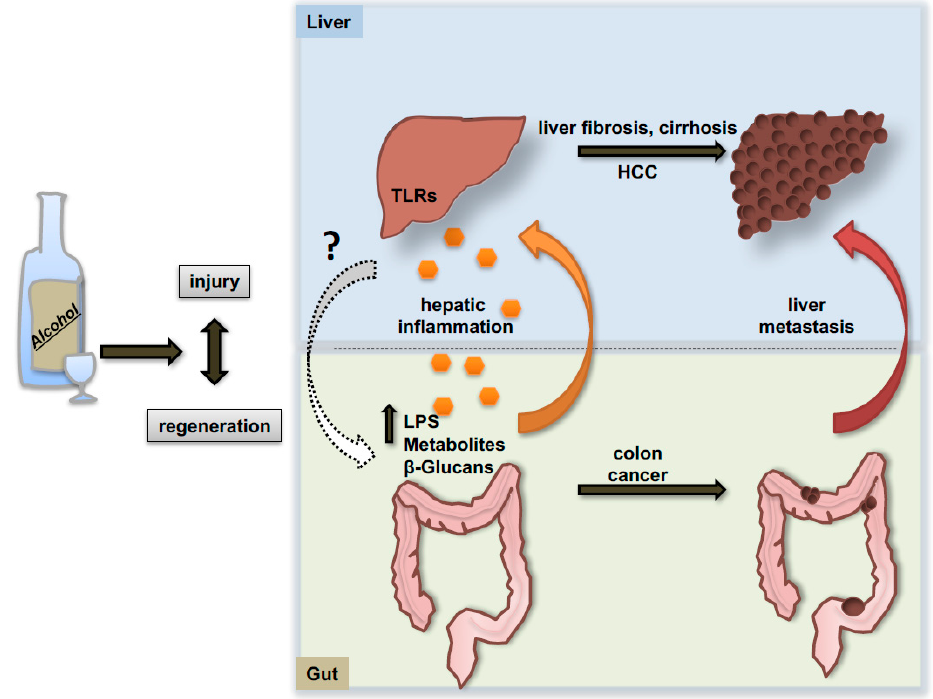
Figure 4. Gut-liver axis in the patho-physiology of alcoholic liver disease. Alcohol cyto-toxicity strongly affects the balance between hepatocyte death and proliferation through mechanisms not fully understood. Similarly, also the intestinal epithelial cells seem to be particularly susceptible to alcohol toxicity resulting in dysbiosis and alteration of intestinal barrier permeability. Bacterial and fungal products together with other metabolites released by the leaky gut contribute to exacerbate the inflammatory response in the liver by binding specific receptor on non-parenchymal hepatic cells, like toll-like receptors (TLRs) and other pattern recognition receptors (PRRs). In turn, injured and inflamed liver might influence intestinal epithelial cell survival and proliferation via systemic release of molecular mediators (left side of the slide). The alternation of alcohol-induce chronic damage and repair might favor the proper environment for the development of intestinal and liver cancers. Moreover, the inflammatory environment generating upon chronic alcohol consumption has been shown to enhance the migration of intestinal metastases towards the liver parenchyma (right side of the slide).